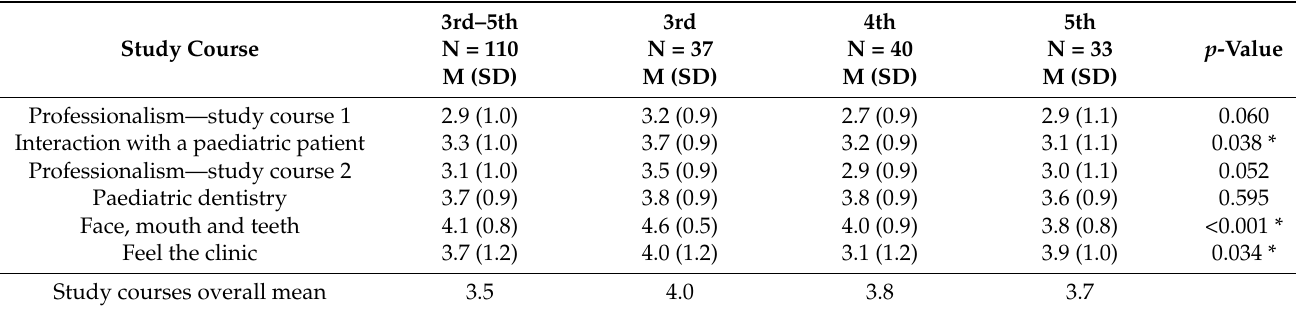
Table 3. Students’ responses to the question asking them to evaluate how the courses tailored specifically for the dental students had laid a foundation for the clinical courses in dentistry. Mean values (M) and standard deviations (SD) of the course